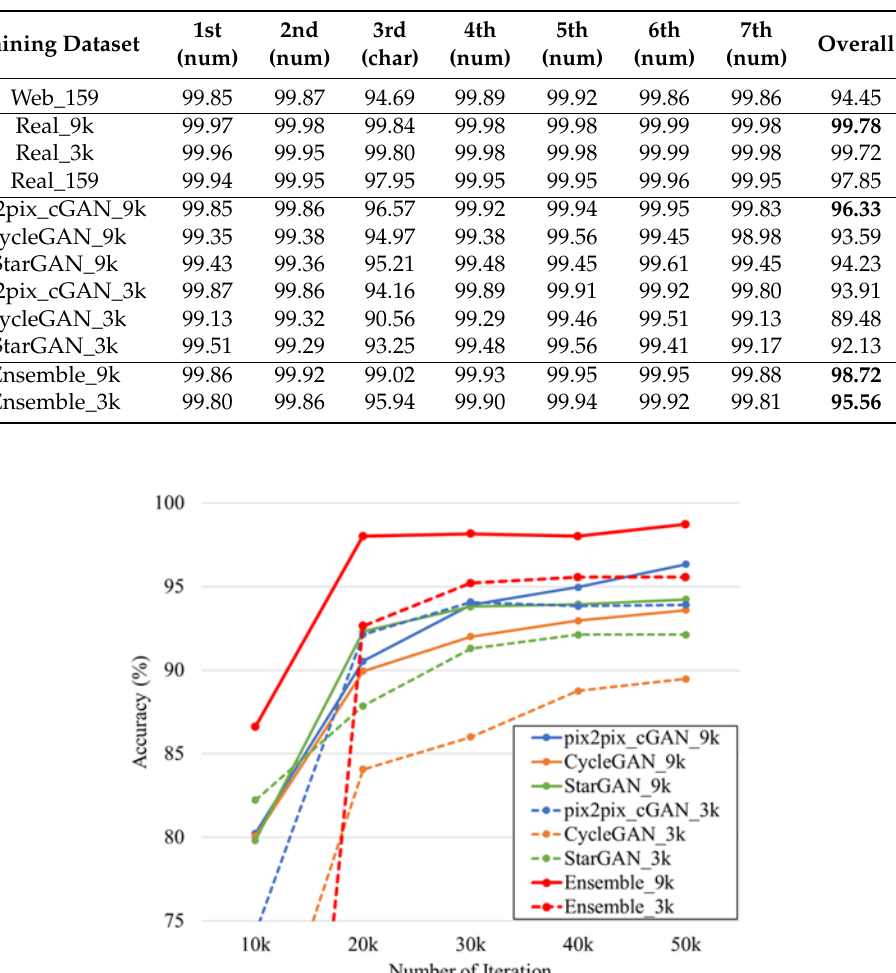
Table 4. Performance comparison of LPCR models trained with the 12 different training datasets.